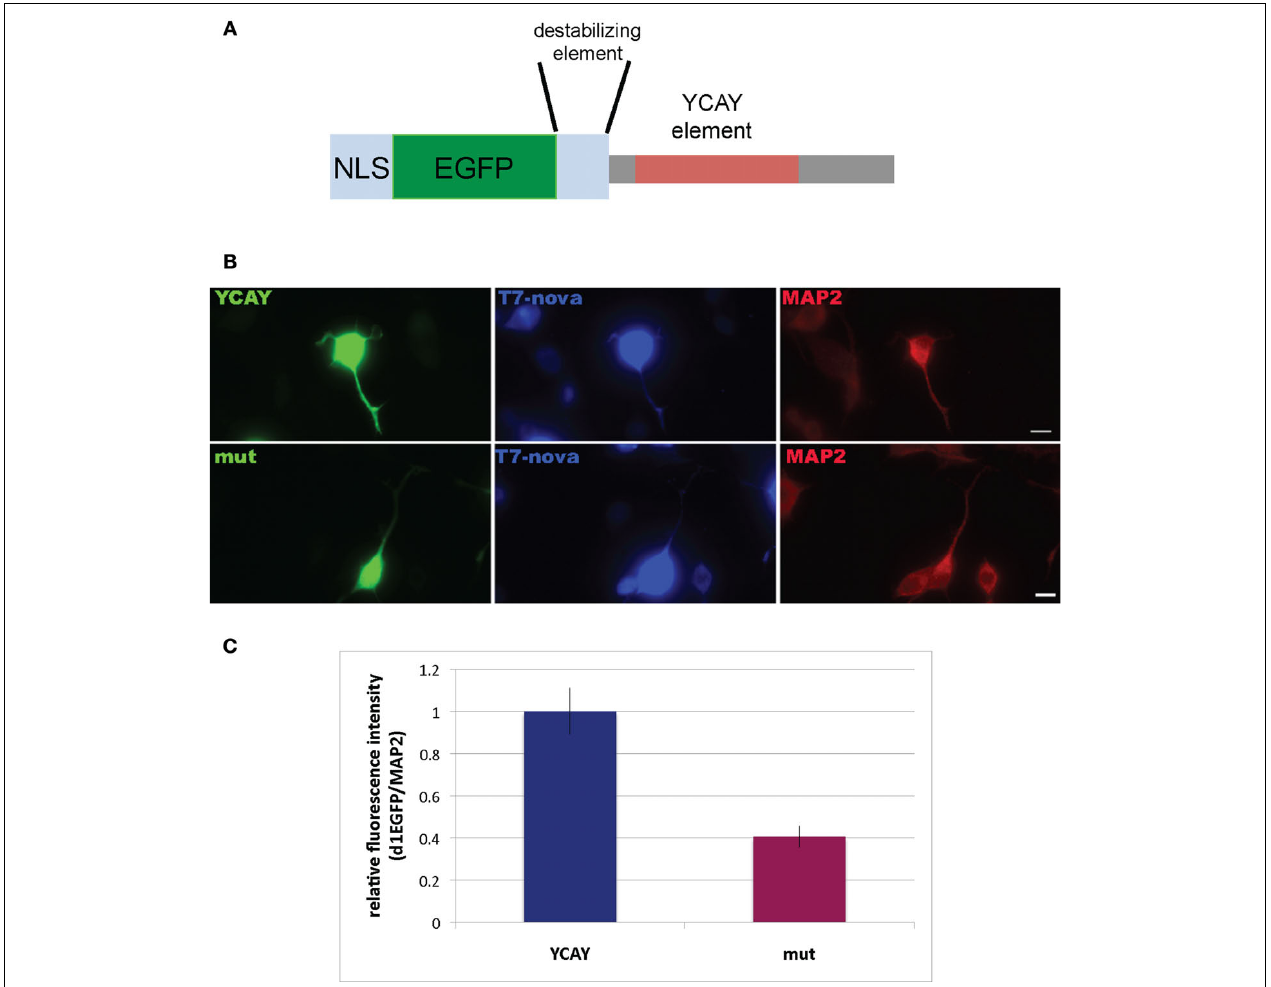
FIGURE 7 | Binding of Nova to the GIRK2-1 YCAY element is necessary for proper localization. (A) Schematic of a reporter encoding destabilized d1EGFP with an M9 nuclear localization sequence (NLS) and the 3 ′ UTR GIRK2-1 YCAY element. An identical construct in which the four YCAY sequences were mutated to YGUY was also made. (B) Comparison of EGFP and MAP2 immunoreactivity in cells co-transfected with plasmid constructs encoding the YCAY or the mutant (“mut”) YGUY element, as indicated, and a construct expressing T7-tagged Nova. The WT Nova target mRNA (green channel, left panel) was localized in distal neurites in transfecting cells expressing the YCAY but not mutant GIRK2-1 element; T7-tagged Nova itself, detected with T7